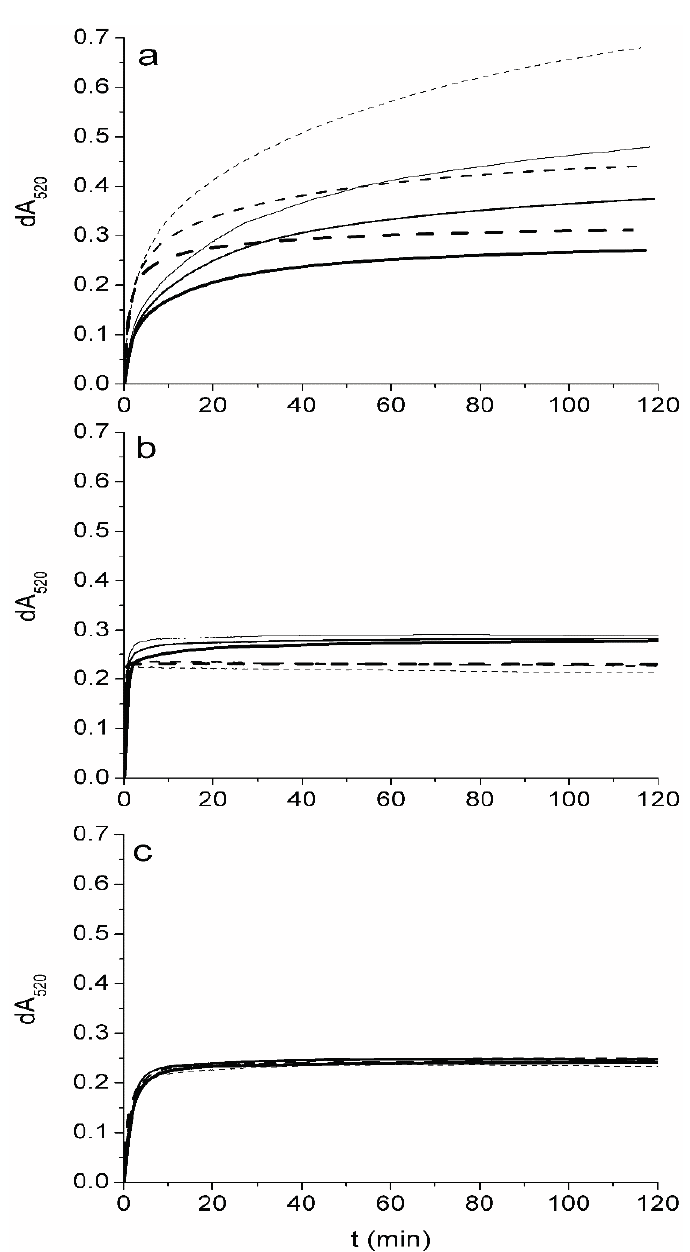
Figure 1. Influence of concentration of α -tocopherol ( broken line ) and γ -tocopherol ( full line ) on the reactivity with DPPH in ( a ) ethyl acetate; ( b ) solution of methanol and 2-propanol with an acid-base pair of Tris base and acetic acid; and ( c ) 2-propanol. Initial concentrations of tocopherols in the assay were 4, 10 and 25 μ mol/L. Values of dA 520 obtained for 4 μ mol/L and 25 μ mol/L are normalized to the results obtained for 10 μ mol/L, by multiplying and dividing dA 520 values by 2.5, respectively. Higher concentration is denoted by thicker